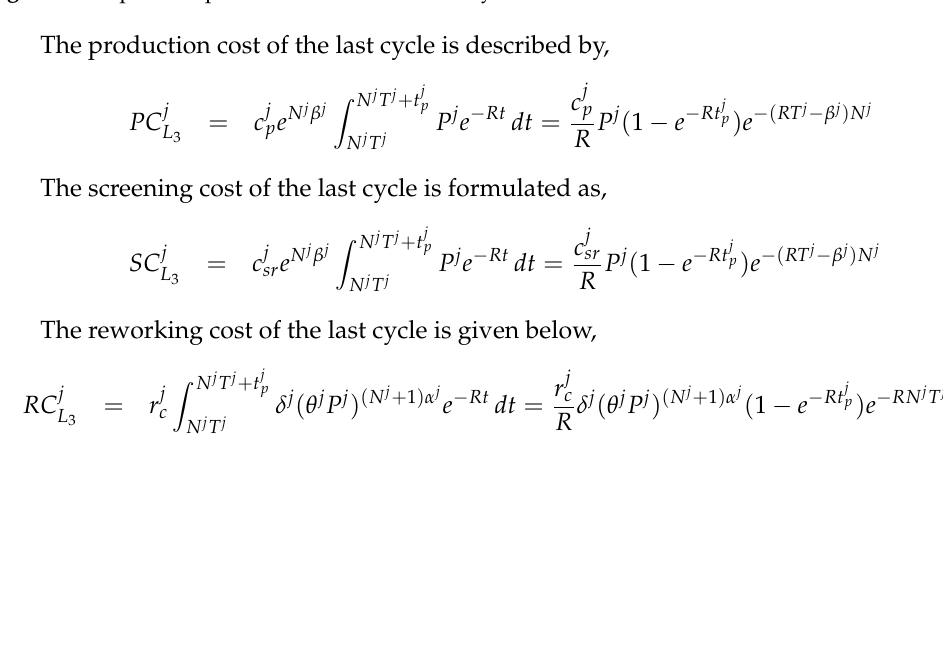
Figure 4. Graphical representation of the inventory model for